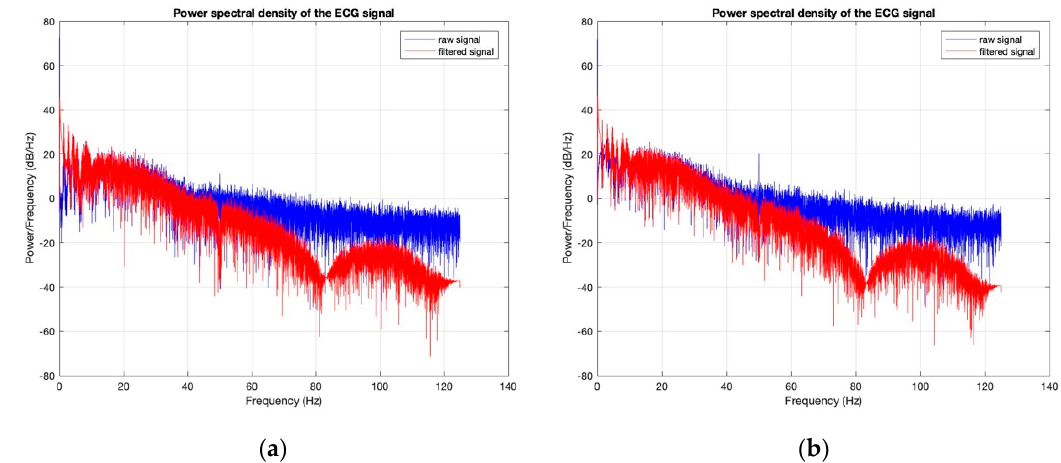
Figure 24. Power Spectral Density of ECG signal obtained by silver-plated electrodes: ( a ) before washing; ( b ) after 50 washing cycles.